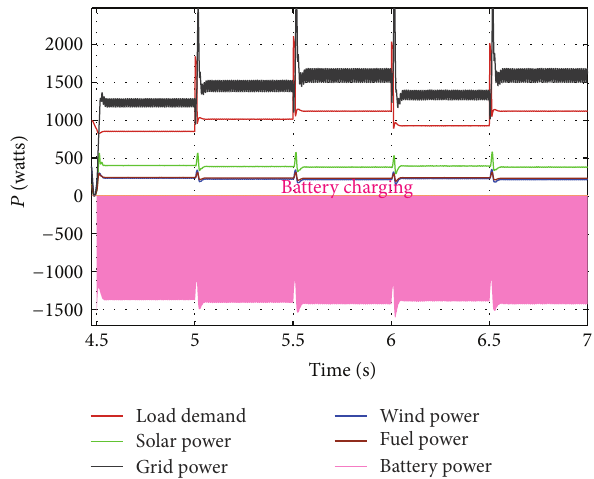
Figure 26: Controller duly connects the AC grid with PV panel, WTG, and fuel cell and also charges the battery with the peak charging current.